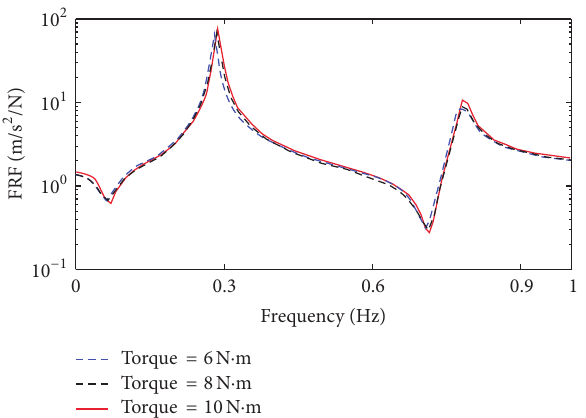
Figure 11: A new series Iwan model.